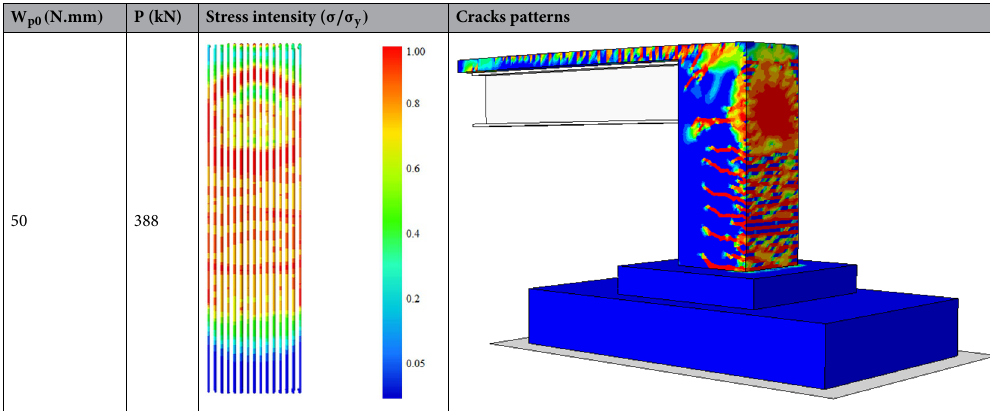
Table 3. W p 0 —load effect on the damage